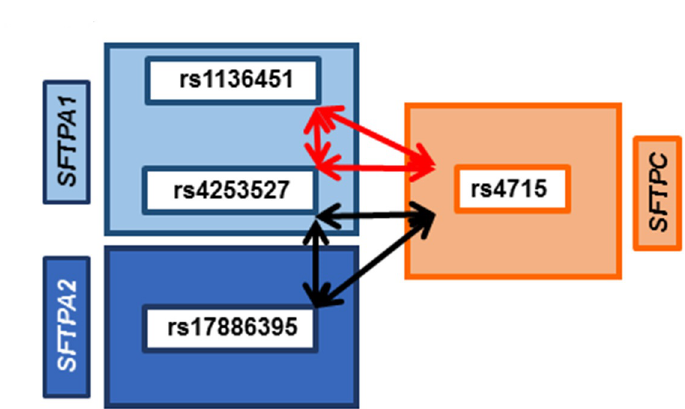
Figure 3. Common association of SNP–SNP interactions with ARF and PDAD. Figure shows SNP–SNP interactions (black and red double head arrows) found in common in two sets of comparisons. In one, comparison between pediatric acute respiratory failure (ARF) to newborn controls; an odds ratio (OR) of 0.5 indicates that these interactions associate with lower risk for ARF. In the other, comparison between those with pulmonary dysfunction at discharge (PDAD) subgroup compared to those who did not develop PDAD after adjusting for age, positive bacterial culture, and number of ventilator days, an OR of 2 to 2.5 indicates that these interactions associate with increased susceptibility of ARF survivors to develop PDAD. The SNP of the surfactant gene SFTPC , encoding the hydrophobic SP-C, is depicted within the orange rectangle on the right side; on the left, SNPs of the surfactant genes, SFTPA1 and SFTPA2 , encoding the hydrophilic surfactant proteins SP-A1 and SP-A2, are depicted within the light- and dark-blue rectangle, respectively. Arrows represent the significant interactions in a three-SNPs model. These interactions are intergenic and dominant × dominant × dominant (d1 × d2 × d3) among the SNPs of SFTPA1 , SFTPA2 , and SFTPC . Red arrows represent the d1 × d2 × d3 interactions among two SNPs of SFTPA1 and one SNP of SFTPC (rs1136451 × rs4253527 × rs4715, p = 0.00002–0.008), while black arrows represent three SNP interactions among the SNPs of SFTPA2 , SFTPA1 , and SFTPC (rs17886395 × rs4253527 × rs4715, p = 0.0001–0.005). Of note, rs4253527 ( SFTPA1 ) and rs4715 ( SFTPC ) are common in both interactions and represent both hydrophilic and hydrophobic surfactant